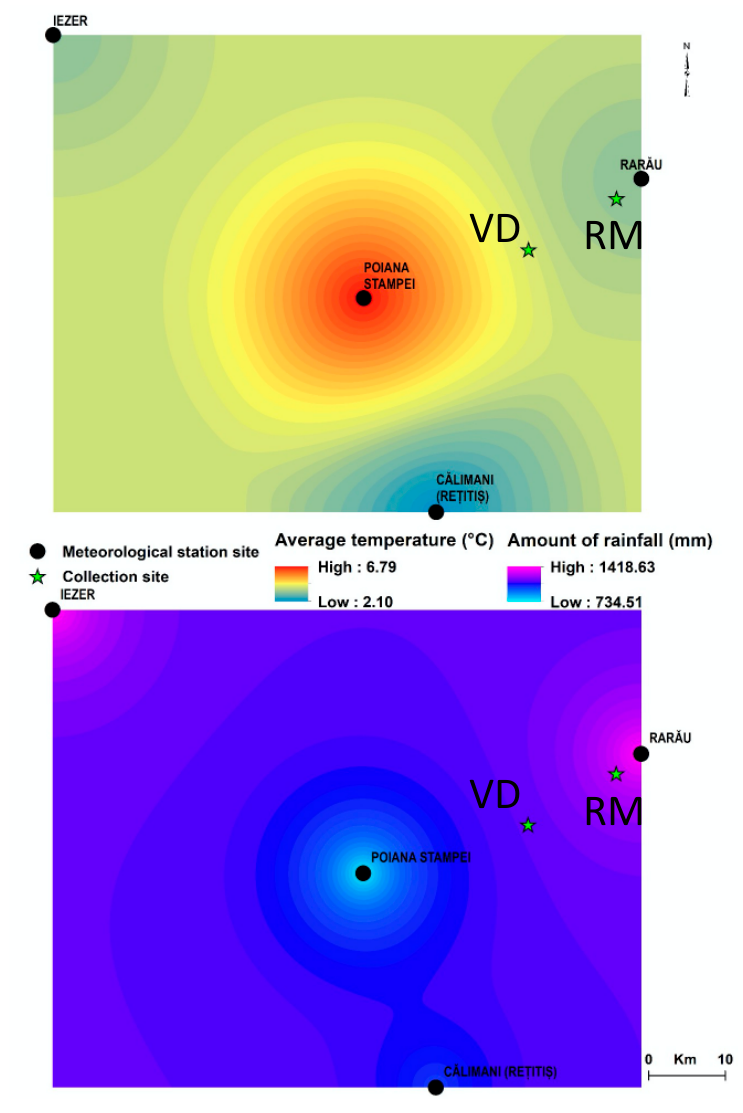
Figure 2. Map of average annual temperatures and average annual cumulative precipitation level for 2020 (sample collection year), for the two collection sites, based on the interpolation of data from 4 weather stations in the region (Poiana Stampei, Rar ă u, C ă limani-Re ț iti ș , Iezer). The collection sites are labelled on the climatic maps as VD, for the Vatra Dornei sample, and RM, for the Rar ă u Mountains sample. Data source: meteomanz.com (accessed on 7 April 2022) [29].